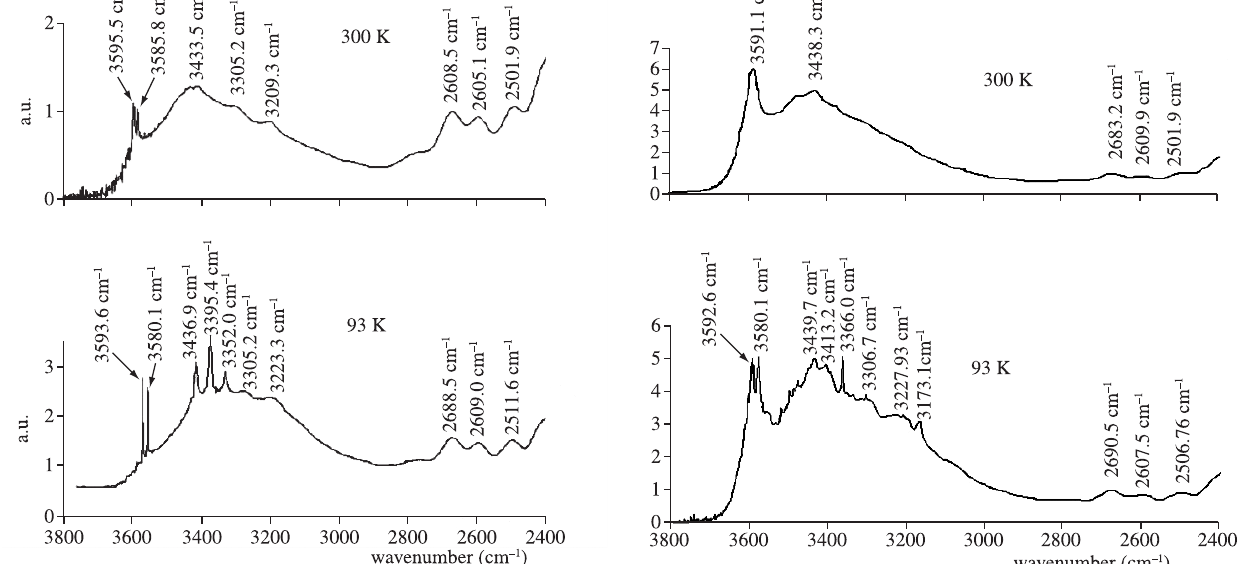
Figure 2. Infrared spectra at 300 and 93 K of the amethyst from Uberlândia, Minas Gerais, Brazil after heating to colorless